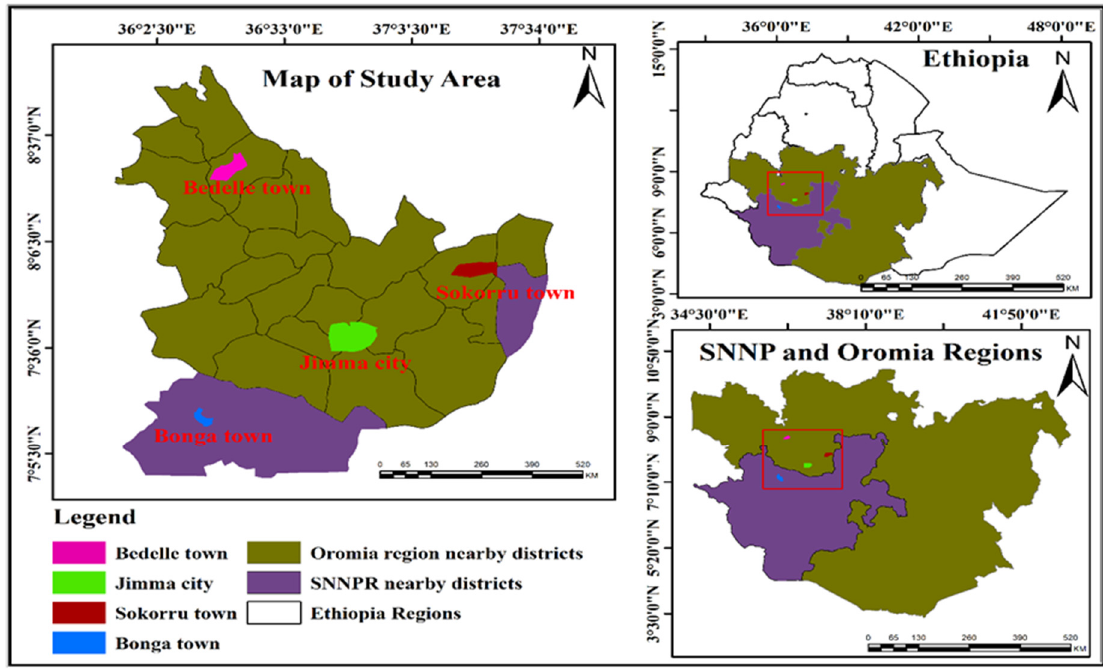
Figure 1. Map of the study area.